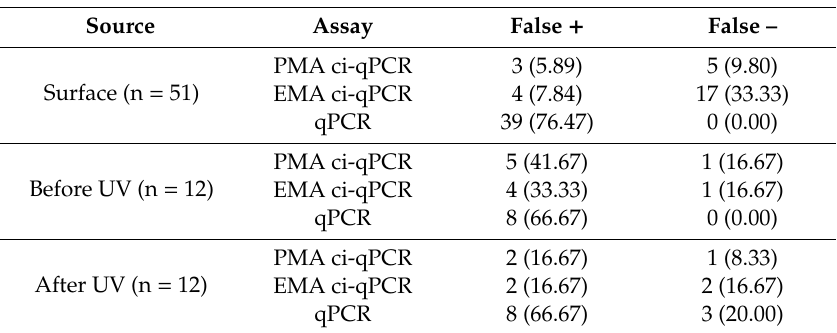
Table 2. Reduction of presumably false-positive signals from conventional qPCR and EMA / PMA ci-qPCR compared to cell-culture based (representing 100%) assays for surface (n = 51) and treated wastewater (combined pre- and post-UV; n = 24) samples. False +/ − for Detection of Infectious HAdV Source Assay False + False – PMA Surface (n = 51)